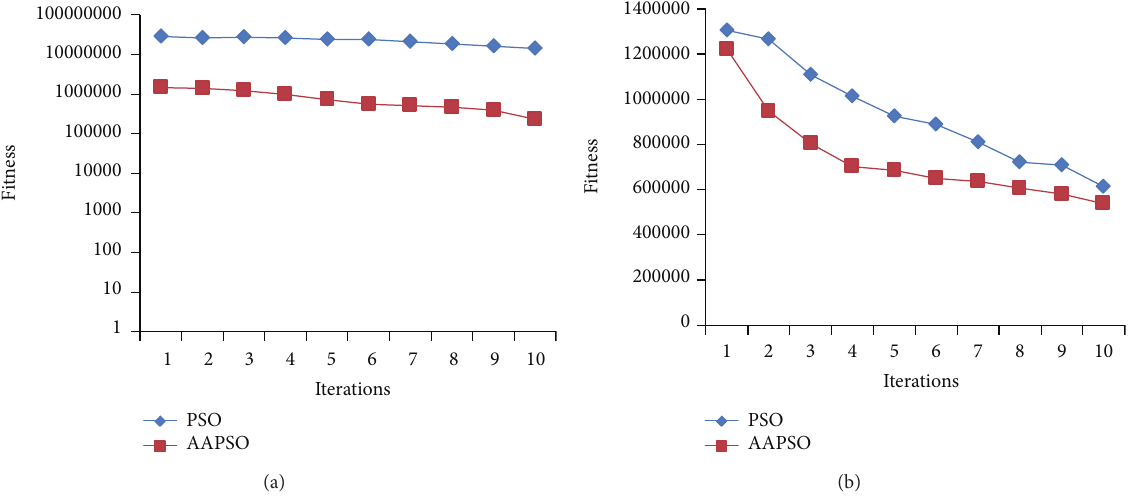
Figure 6: Performance of AAPSO and PSO methods from (a) YALE [5] database and (b) CASIA [6]